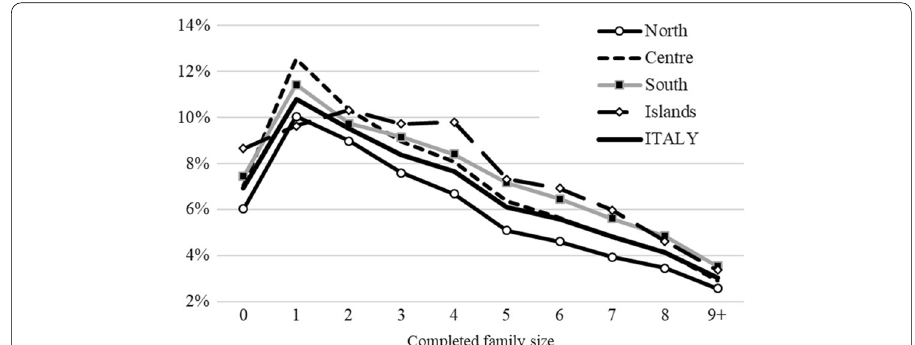
Fig. 1 Survival chances between 1931 and 1961 of the cohorts born before 1887 by completed family size (CFS), in Italy (ever-married women, aged 45 years and over at the start of the period and 75 years and over at its end). Ever-married women observed in 1931 at 45 years and over, and in 1961 at 75 years and over. Source : Istat (1936, 1974) and authors’